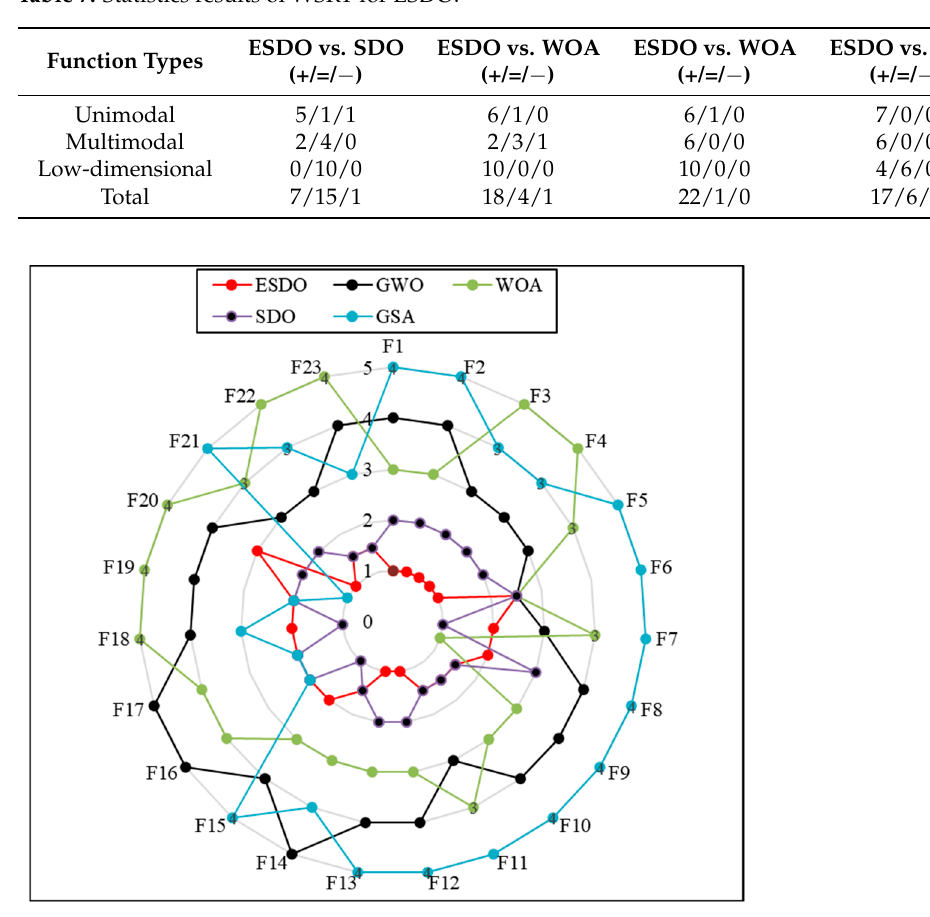
Table 7. Statistics results of WSRT for ESDO.